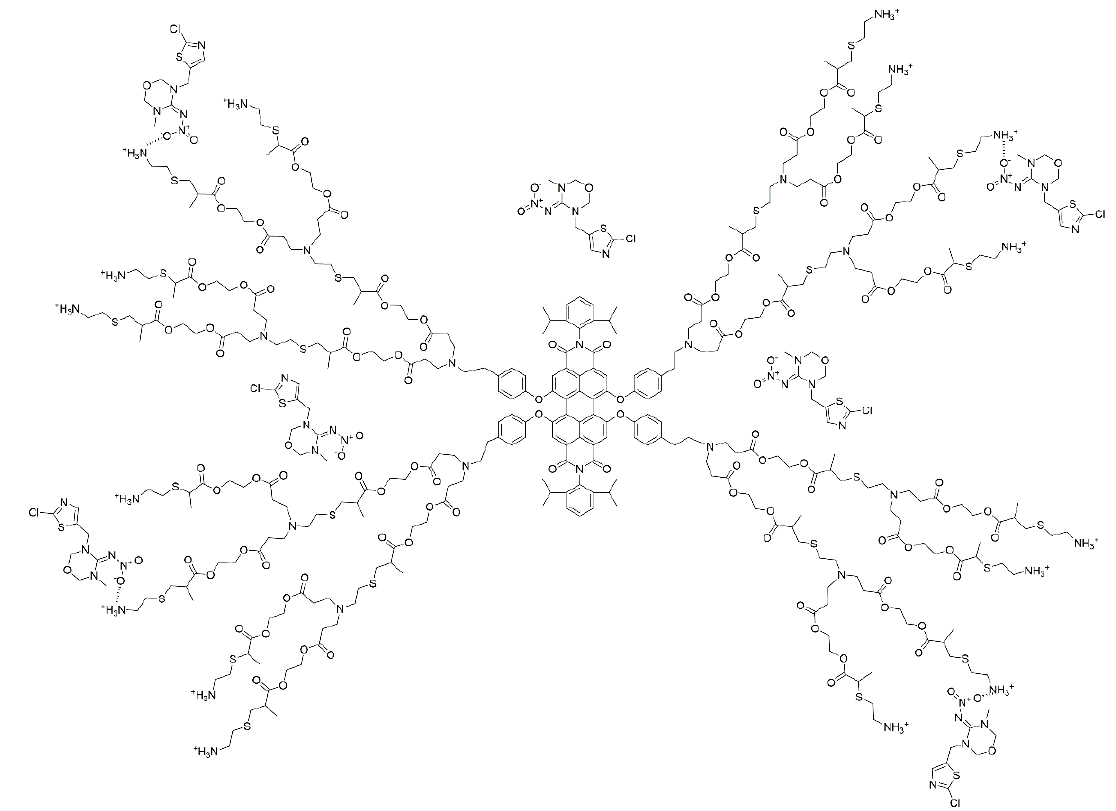
Figure 4. Structure of fluorescent perylene-3,4,9,10-tetracarboxydiimide chromophore core as a nano-device for pesticides .